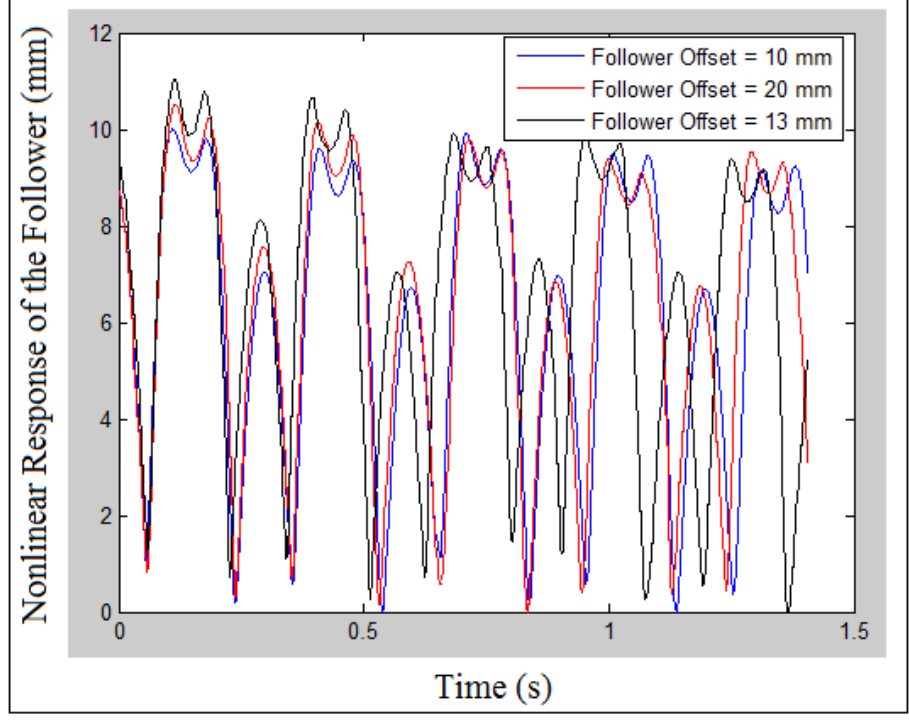
Figure 6. Nonlinear response when the follower offsets to the right at (O = 10, 20, and 30 mm). Figure 7 shows the nonlinear response of the follower when the follower offsets to the right (O = 10 mm) and follower guide’s clearance (16 mm) at different cam speeds (N = 200, 400, and 600 rpm) and different impact coefficient of restitution (0.2, 0.3, and 0.4) receptively. The dwell stroke is clear at cam speed (N = 200 rpm) while the dwell stroke starts disappearing with the increase of cam speeds (N = 400, and 600 rpm) and with the increase of the coefficient of restitution (0.3, and 0.4). The periodic motion of the nonlinear response of the follower is indicated at cam speeds (N = 200, and 400 rpm), while the chaotic motion is depicted at cam speeds (N = 600 rpm) in which the rise, dwell and return strokes completely disappear with the increase of cam speeds and the impact coefficient of